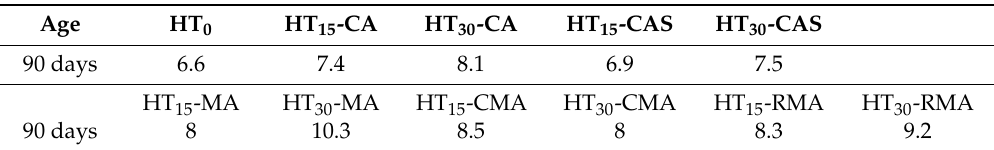
Table 10. Results of water absorption at 90 days of hollow tiles, as a function of the aggregate type, dosaging method (see Table 6 for